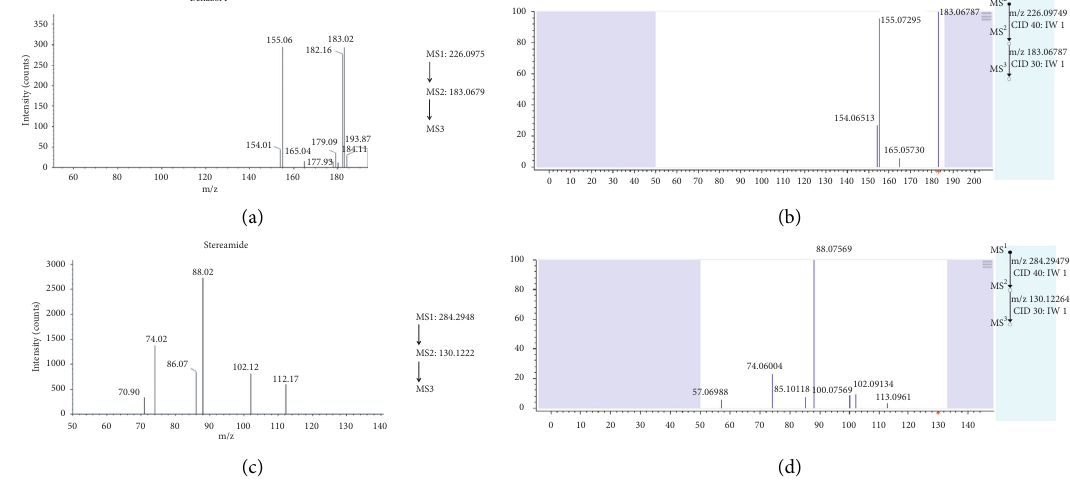
Figure 2: (a) Experimental MS 3 spectra and (b) mzCloud MS 3 spectra for benazol P and stearamide.